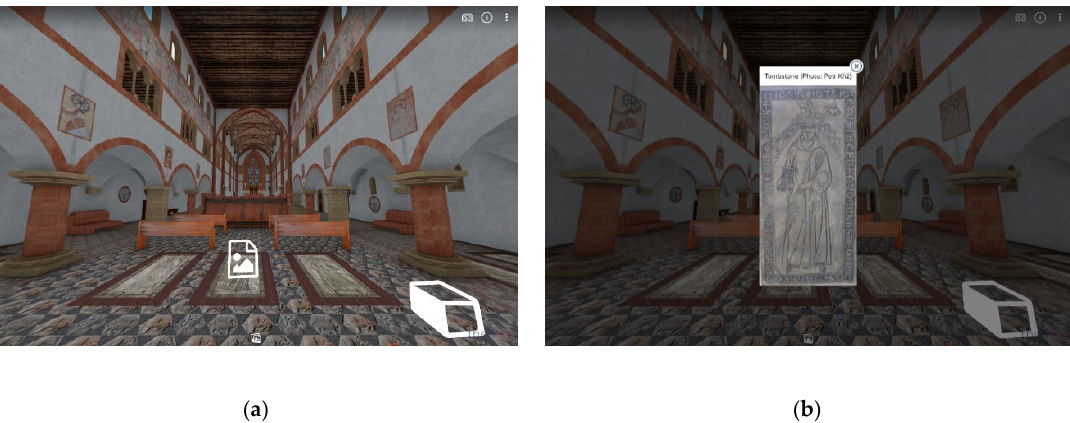
Figure 16. The virtual museum application with hotspots ( a ) that can be studied in detail in its own pop-up viewer ( b ).